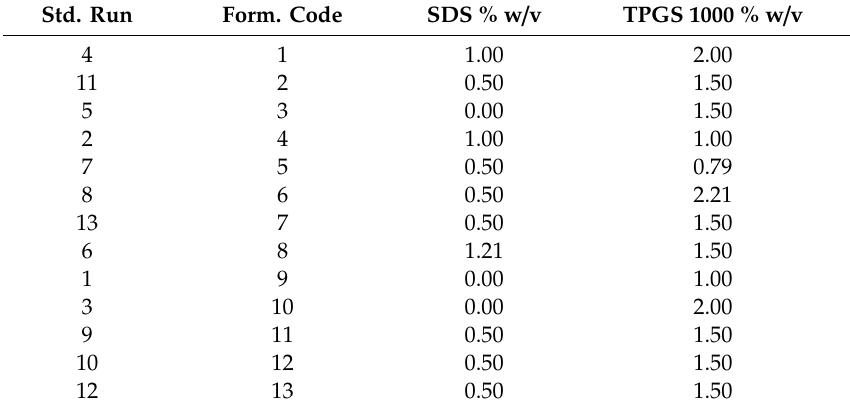
Table 1. Summary of CCD experiments for nano co-crystals (NCC) optimization. Std. Run Form.